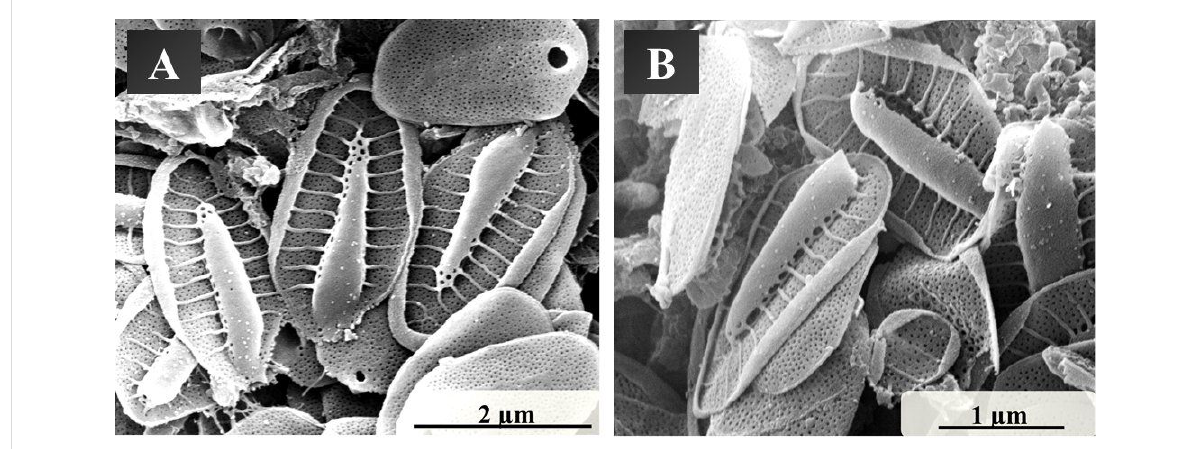
Figure 2: Scanning electron micrographs of the skeletal elements of Synura petersenii , showing the skeleton from various angles (A, B).